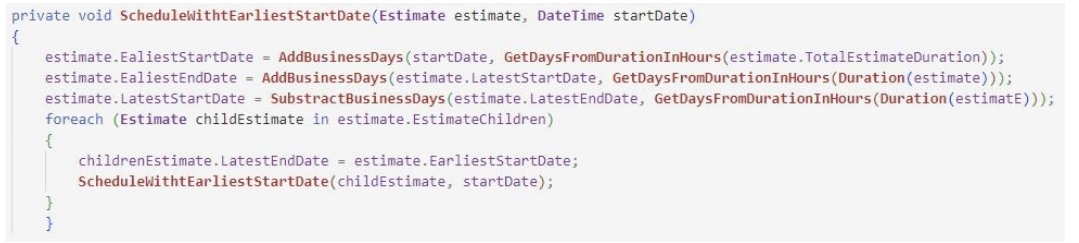
Figure 5. Pseudocode, which calculates the start and end, dates of each activity, depending on the total duration in hours and starting from the start date.